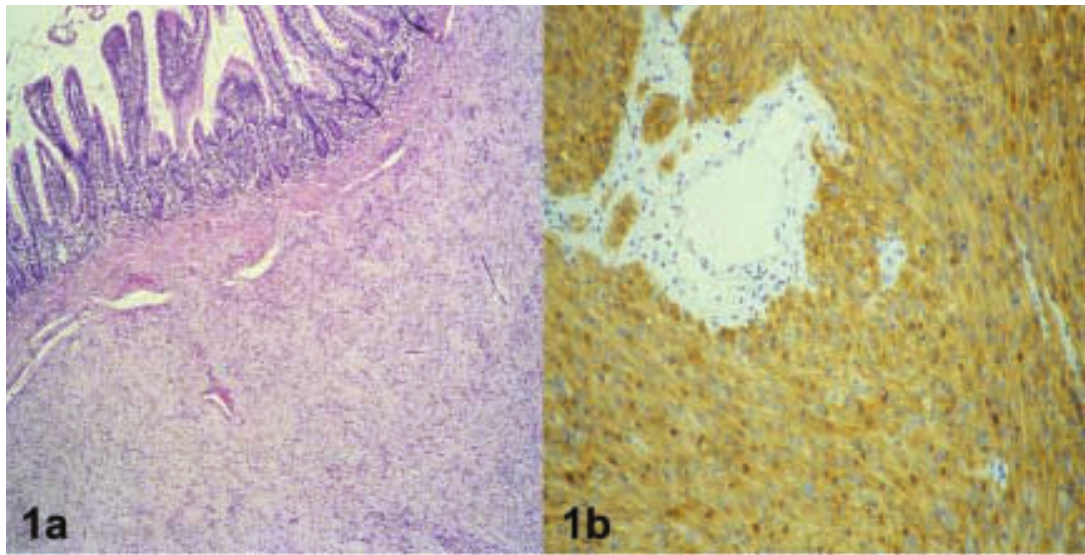
positive tumoral cells for KIT (brown